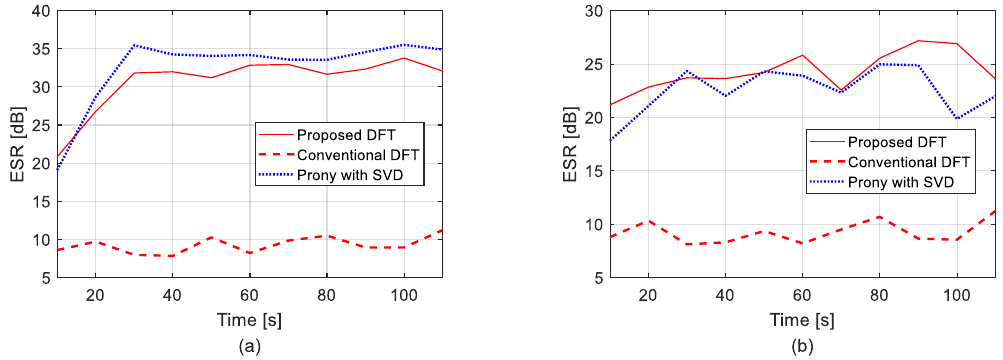
Figure 3. ESRs of the three methods in the simulation: ( a ) 50 dB SNR; ( b ) 10 dB SNR. Energies 2019 , 12 , x FOR PEER REVIEW